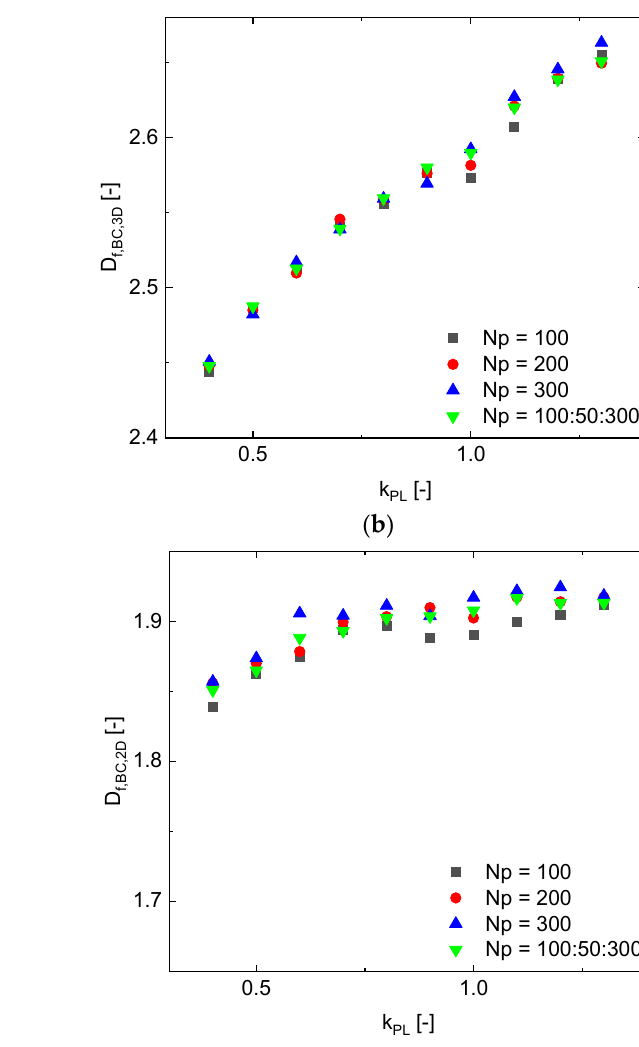
( b ) D f , PL = 2.8 and BC in 3D, ( c ) D f , PL = 1.8 and BC in 2D, ( d ) D f , PL = 2.8 and BC in